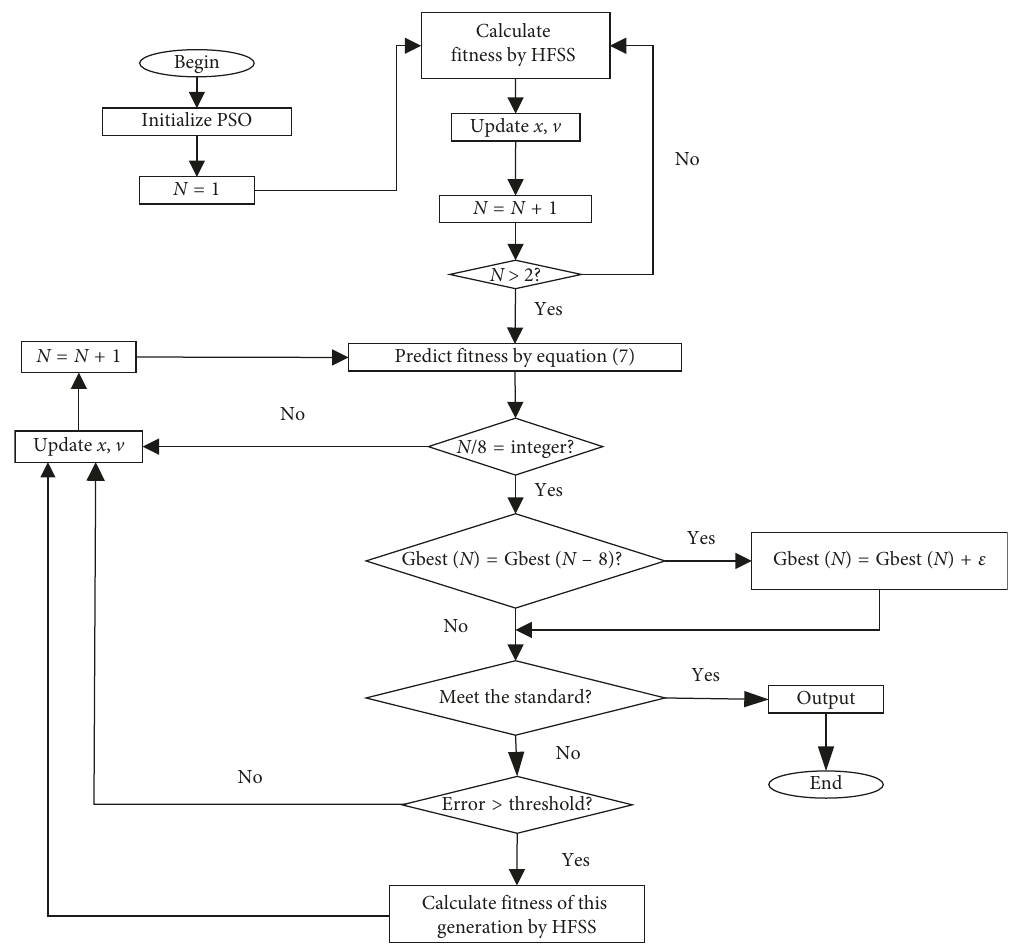
Figure 1: Flow chart of SFEPSO